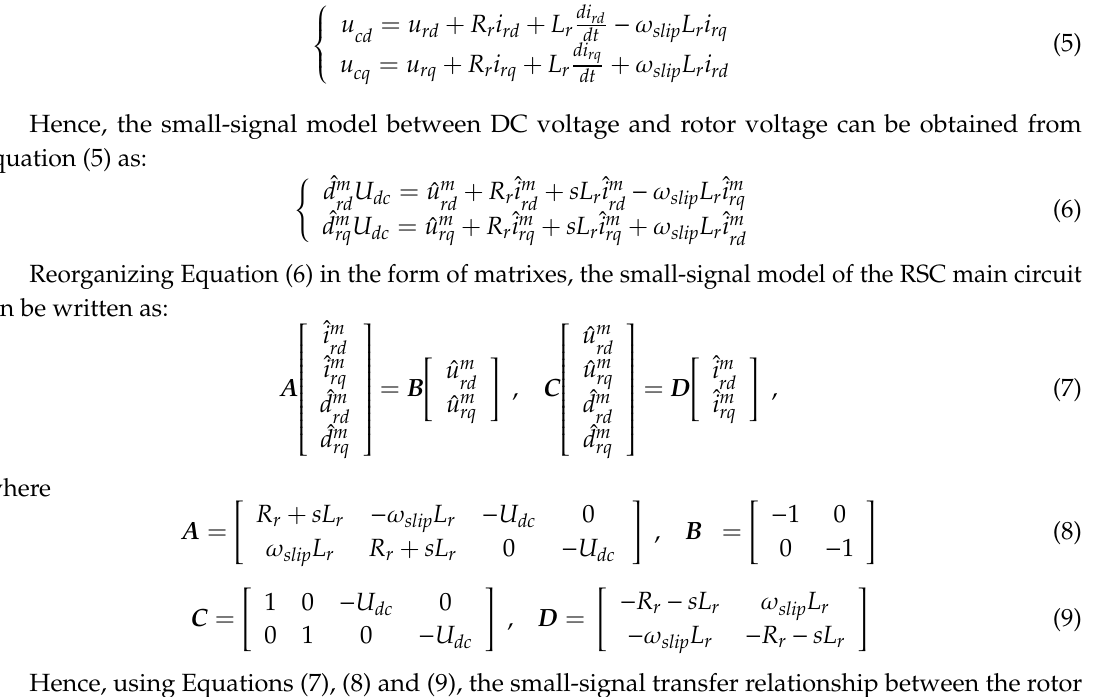
Figure 5. The small-signal transfer diagram of the RSC circuit in DFIG. 2.2. Small-Signal Modeling of RSC Control with PLL